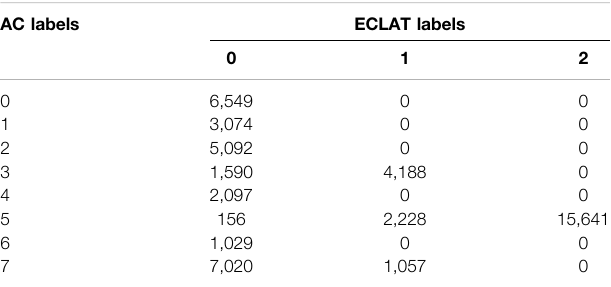
TABLE 2 | Contingency table comparing the agglomerative clustering (AC) labels of the magnetotail electron data to the original ECLAT labels (0 (cid:2) PS, 1 (cid:2) PSBL, and 2 (cid:2)